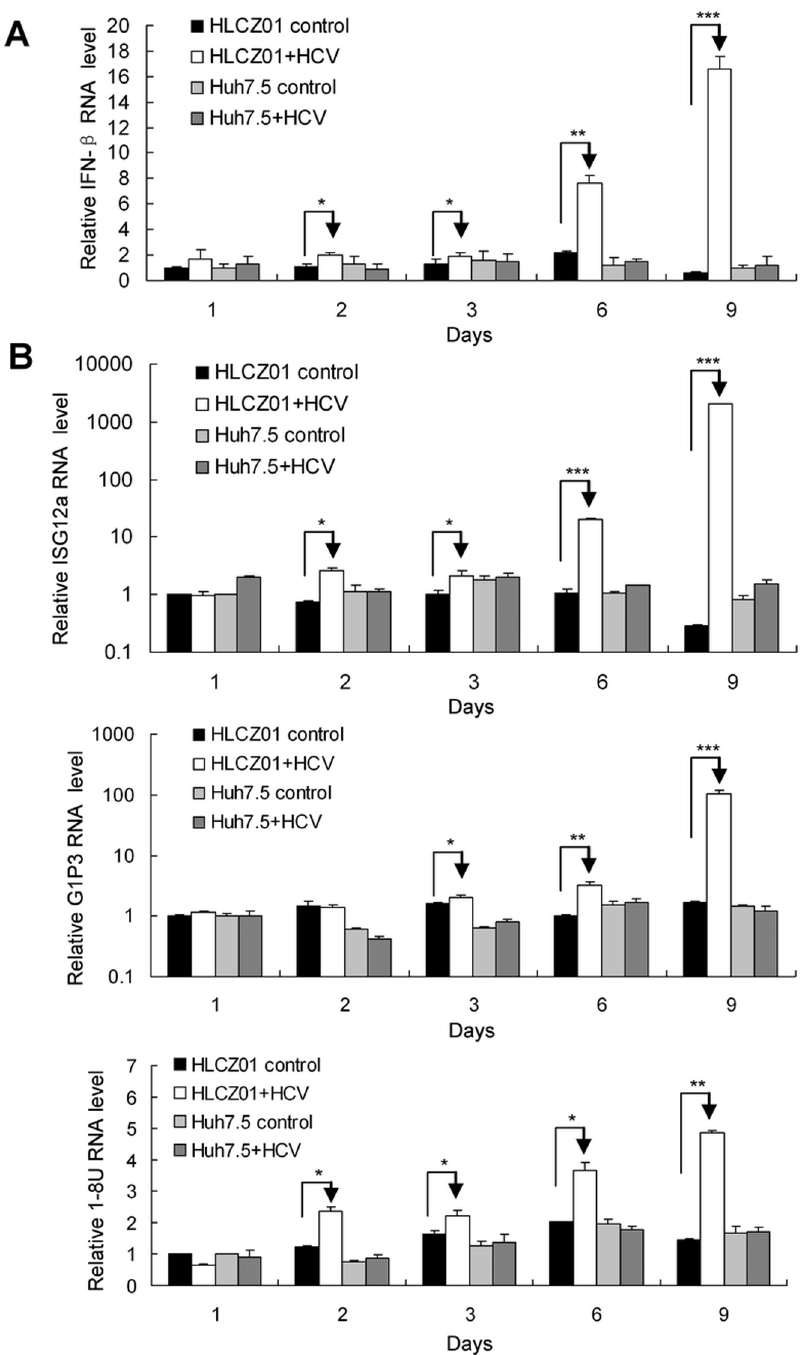
Figure 2. HCV infection induces type I IFN and ISGs in HLCZ01 cells. ( A ) Kinetics of IFN- b in HCV-infected HLCZ01 cells. HLCZ01 and Huh7.5 cells were infected with JFH1 virus at MOI of 0.1. Cells were harvested for total RNA extraction at different time points. The kinetics of induction of IFN- b was analyzed by real-time PCR and normalized with GAPDH. ( B ) Kinetics of ISG12a, G1P3 and 1–8U in viral-infected HLCZ01 cells. HLCZ01 and Huh7.5 cells were treated as described in part A. The expression of ISG12a, G1P3 and 1–8U mRNA was analyzed by real-time PCR and normalized with GAPDH respectively. If not stated otherwise bar graphs represent means of three independent experiments. doi:10.1371/journal.pone.0094501.g002 Inhibition of ISG12a expression prevents the sensitization to designed to silence ISG12a in HLCZ01 cells (Figure 5D). The etoposide-induced apoptosis [26]. In our study, HCV infection efficiency of ISG12a shRNA knockdown was confirmed highly induced ISG12a expression (Figure 2B). To assess the (Figure 5D). As expected, silencing of ISG12a reduced PARP inactivation as assessed by the appearance of the cleaved impact of ISG12a on apoptosis of HLCZ01 cells induced by HCV infection, we used shRNA constructs pSilencer-ISG12a shRNA fragments in HCV-infected HLCZ01 cells (Figure 5E). Flow